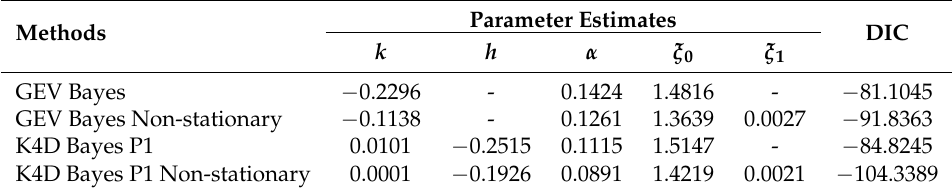
Figure 12. Evolutions of the 20-year and 100-year return levels in time, with 95% highest posterior density intervals (dashed lines) on the maximum sea-levels (unit: m) at Fremantle, Western Australia, 1897–1989. Blue lines for 20-year and red lines for 100-year return levels. Table 4. Comparison of the estimates and deviance information criterion (DIC) obtained from the stationary and non-stationary GEVD and the K4D using Bayesian methods with the prior P1 given in the Section 4.2 for the annual maximum sea-levels (unit: meter) recorded at Fremantle, Western Australia,